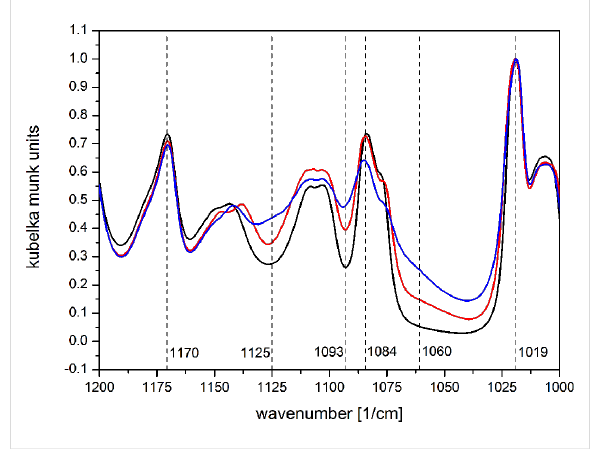
Figure 2: Diffuse reflectance FTIR spectra of uncoated (black) and coated (28 cycles (red), 112 cycles (blue)) polycarbonate membranes. Spectra were normalized to the band at 1019 cm − 1